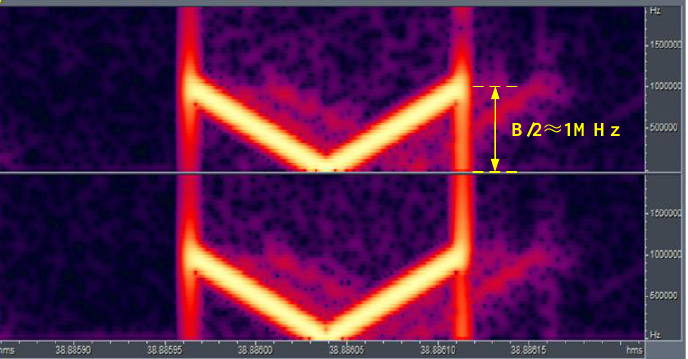
Figure 13. Time-frequency spectrum of the collected IQ data of the reference channel with single direct wave pulse after partial magnification.